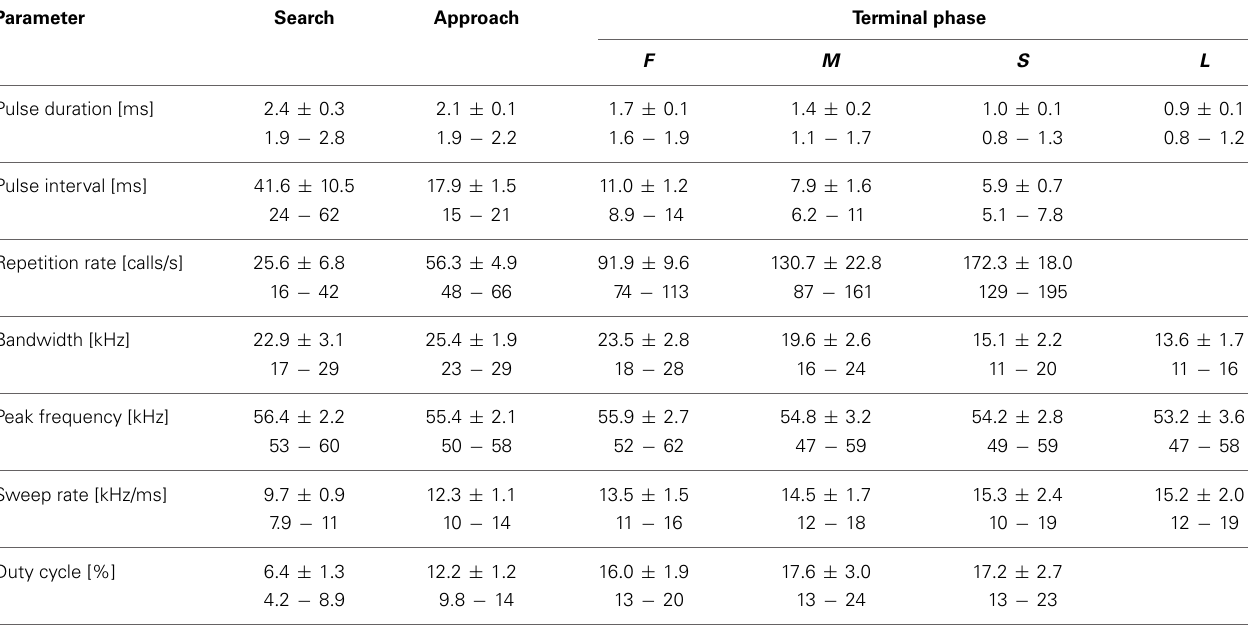
Table 2 | Seven echolocation parameters of nine M. macrophyllum foraging in the flight cage on BCI, Panamá. Parameter Search Approach